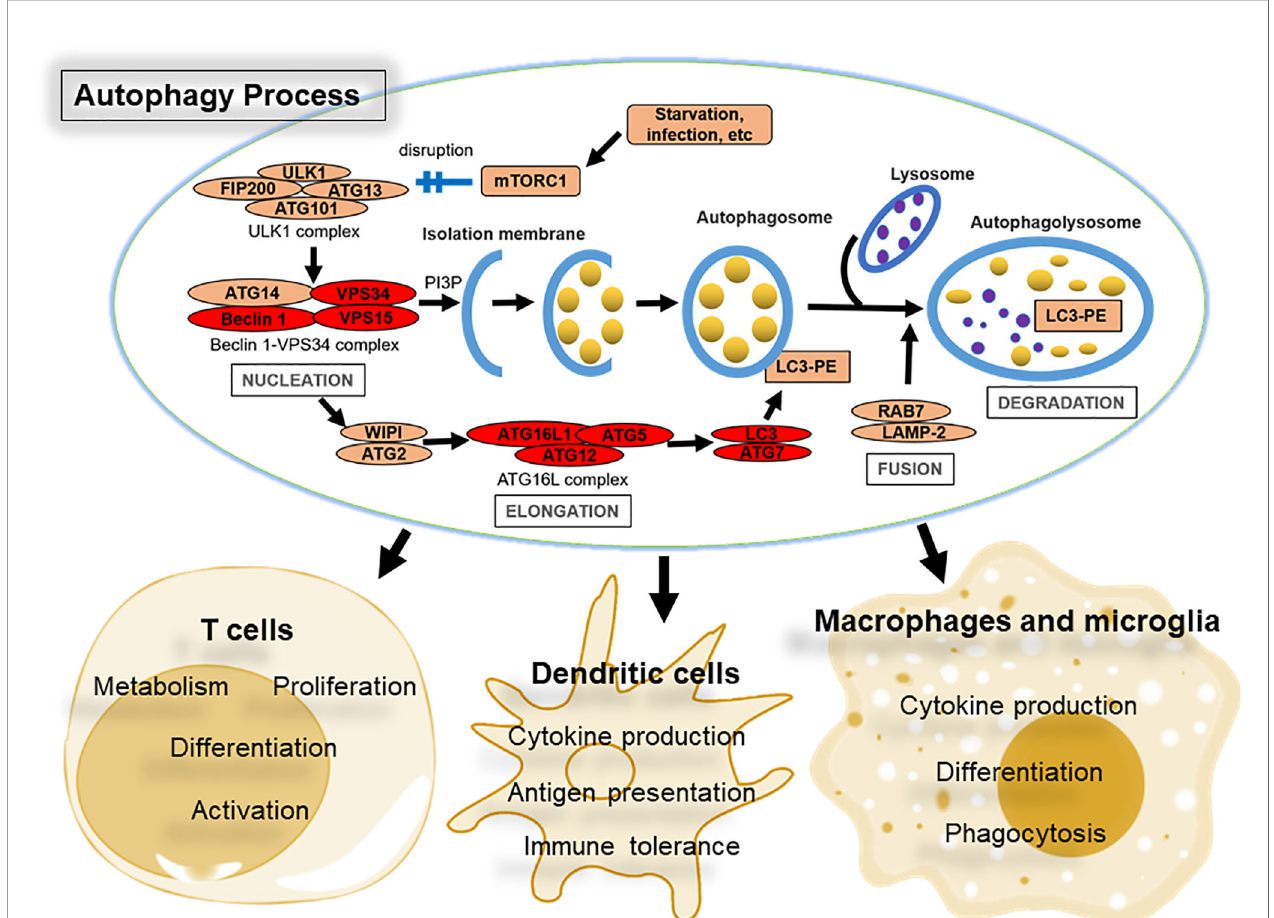
FIGURE 1 | Overview of the autophagy pathway and its role in immune cells that control CNS autoimmunity. The four major steps in the autophagy process (nucleation, elongation, fusion, and degradation), together with key protein complexes and core factors, are indicated. Brie fl y, autophagy is initiated by nutrient starvation and other stress signals leading to the dissociation of the mechanistic target of rapamycin (mTOR) from the mTOR substrate complex (ULK1/2, ATG13, RB1CC1/FIP200, and ATG101). This dissociation leads to the recruitment of the class III phosphatidylinositol 3-kinase (PtdIns3K) complex, which includes at least BECN1/Beclin 1, PIK3C3/ VPS34, PIK3R4/VPS15, and ATG14L that phosphorylates phosphatidylinositol to generate phosphatidylinositol-3-phosphate (PtdIns3P or PI3P). The ATG12-ATG5- ATG16L1 complex mediates the formation of pre-autophagosome structures. During this process, LC3 is conjugated to phosphatidylethanolamine with the assistance of ATG4, ATG7, and ATG3 (E2-like ubiquitin-conjugating enzymes) to generate LC3-II (LC3-PE), and associates with newly formed autophagosome membranes until they fuse with lysosomes to generate autophagolysosomes. The contents of autophagolysosomes are then degraded by lysosomal esterases, lipases, and proteases and recycled to build new cellular components and energy. Proteins shared by autophagy and LC3-associated phagocytosis (LAP) are highlighted in red. The main properties of immune cells impacted by autophagy during MS or EAE are